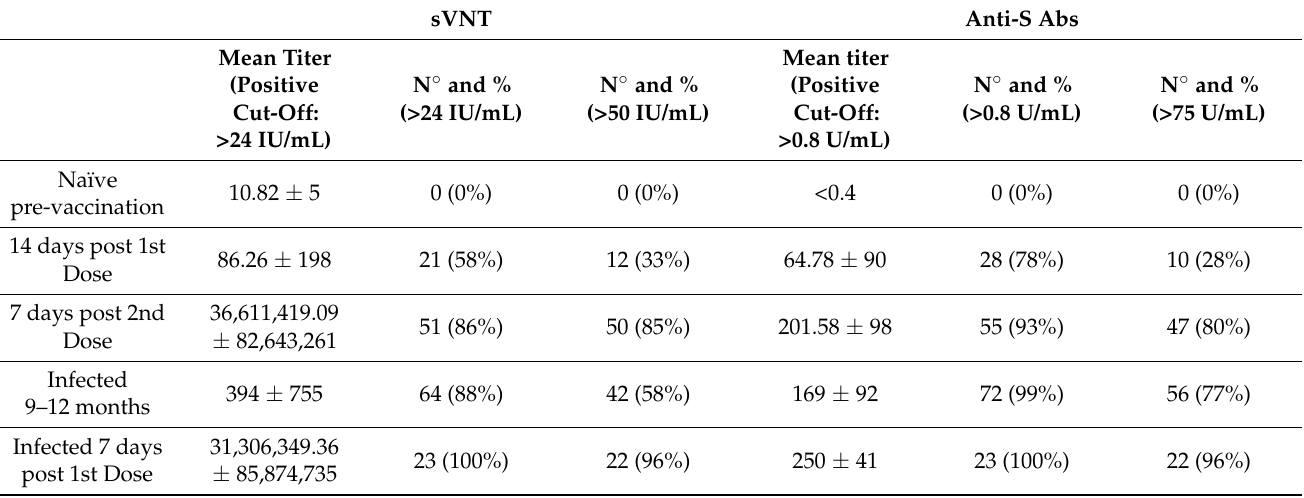
Table 1. Comparison between sVNT and anti-S eCLIA titers in different HCW populations.